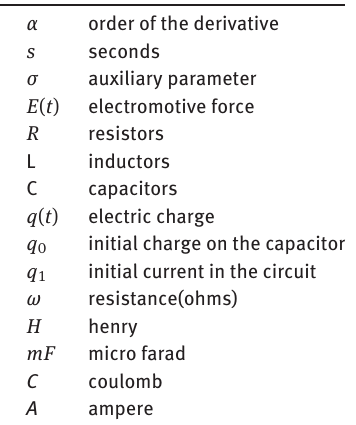
Table 2: List of